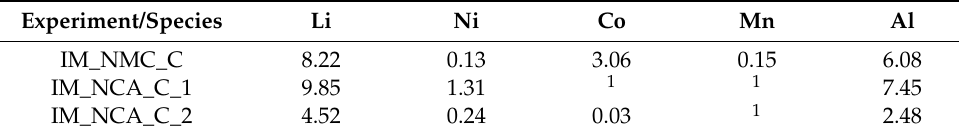
Table 5. Mass fractions of certain metals in the obtained slag phase. (w/%). Experiment/Species